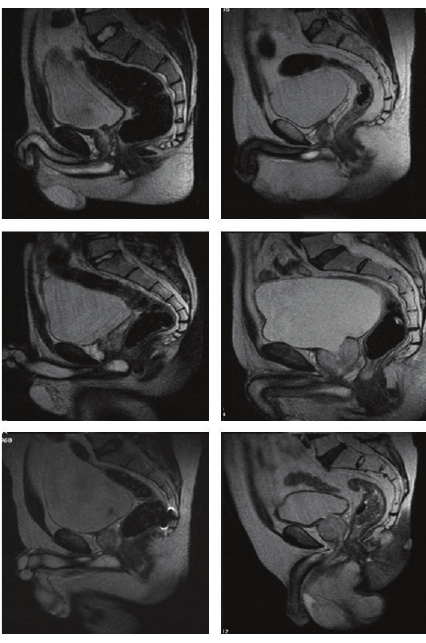
Figure 1: MRI images showing spheric and cone bladder